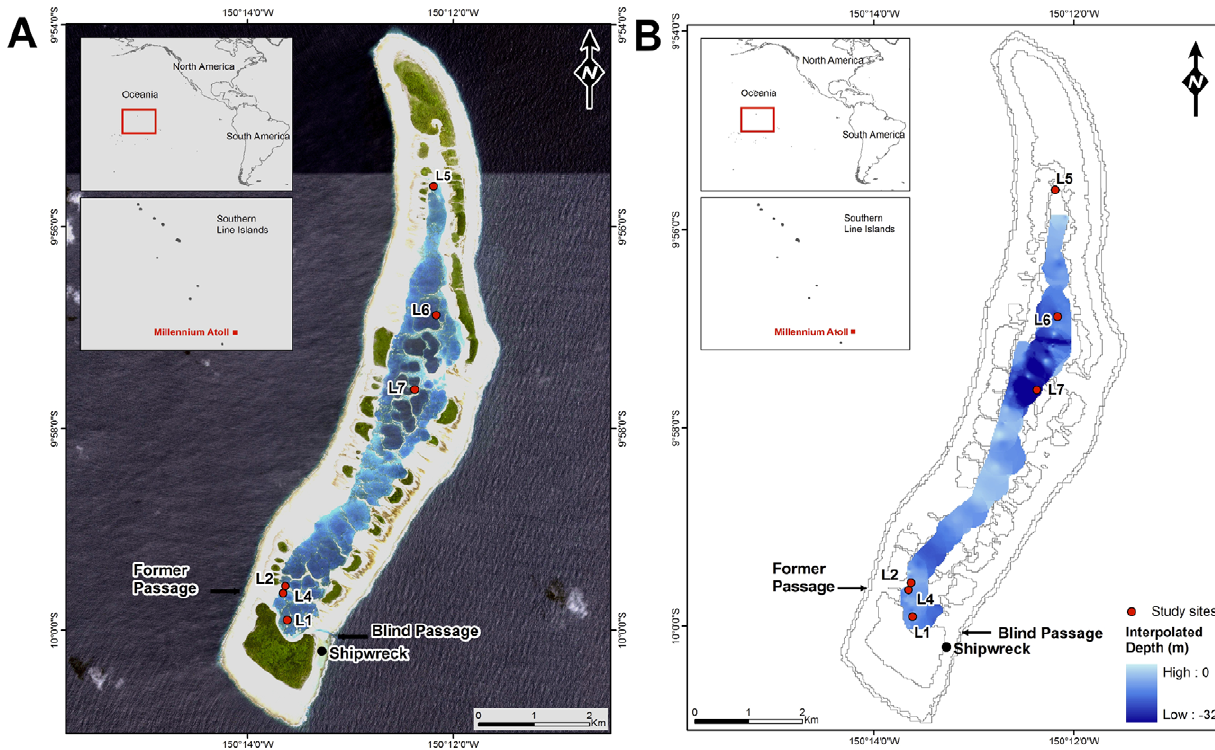
Figure 1. Maps of Millennium lagoon and sites surveyed. A) Satellite map of Millennium indicating the lagoon entrance, shipwreck, former lagoon entrance, and sites surveyed, B) Map of the interpolated depths within the lagoon.